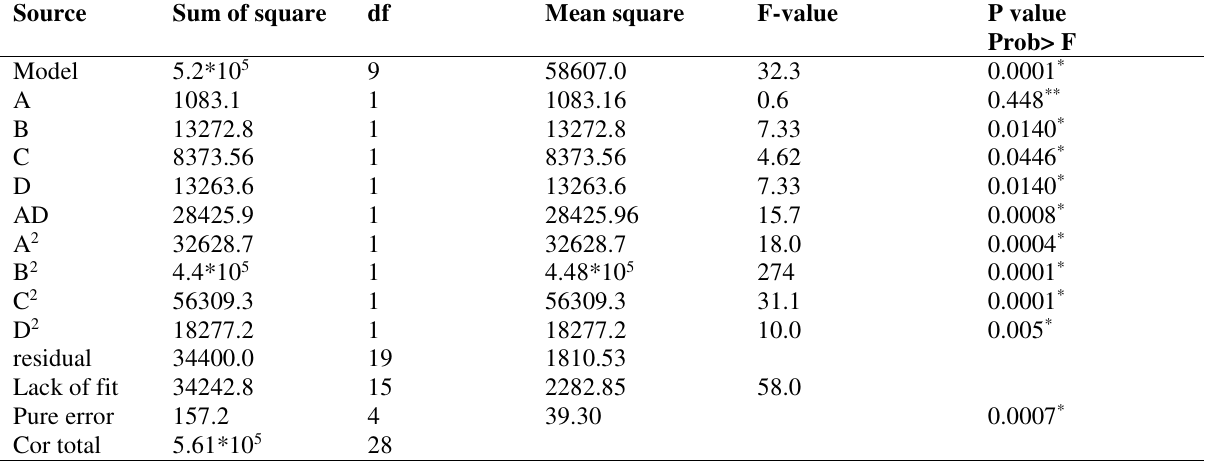
Analysis of variance (ANOVA) for the quadratic modal of prodigiosin production obtained from the experimental results